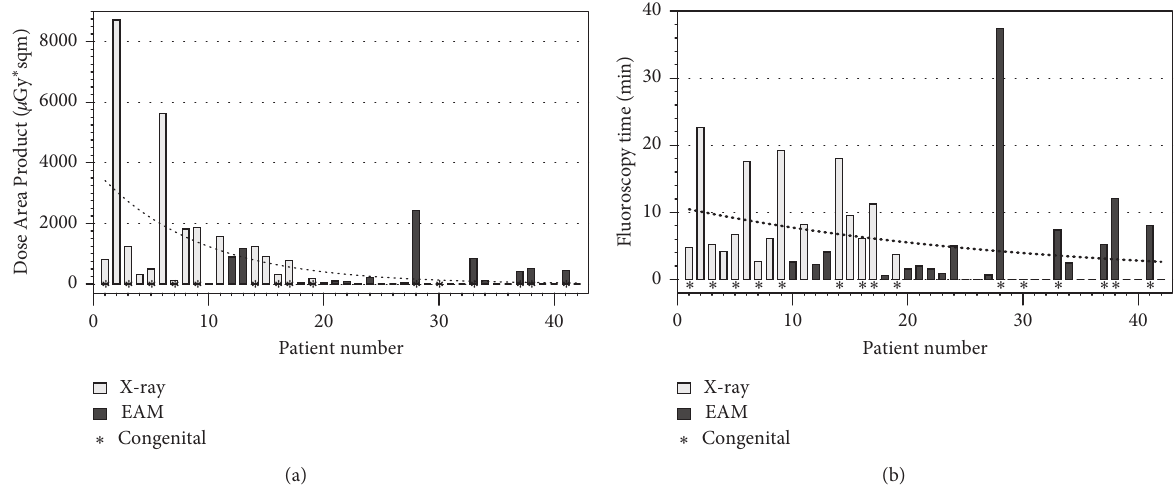
Figure 3: Case-by-case fluoroscopy time (FT) and Dose Area Product (DAP). Boxplots group 1 versus group 2: a significant reduction is evident for both DAP and FTin group 2 (needle visualized on EAM) compared to group 1 (standard fluoroscopy guidance of the needle). (a) Dose Area Product in consecutive patients. (b) Fluoroscopy time in consecutive